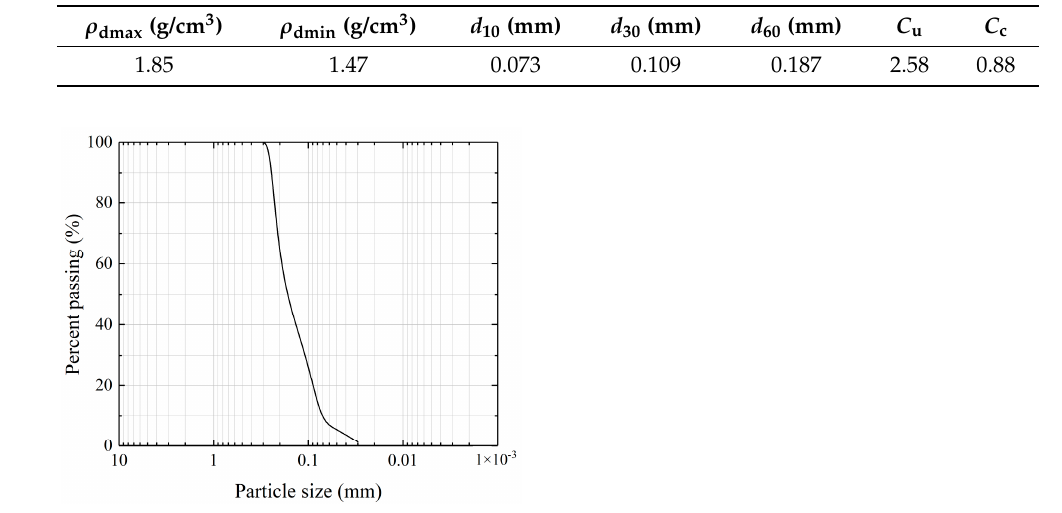
Figure 1. Particle size distribution curve of the aeolian